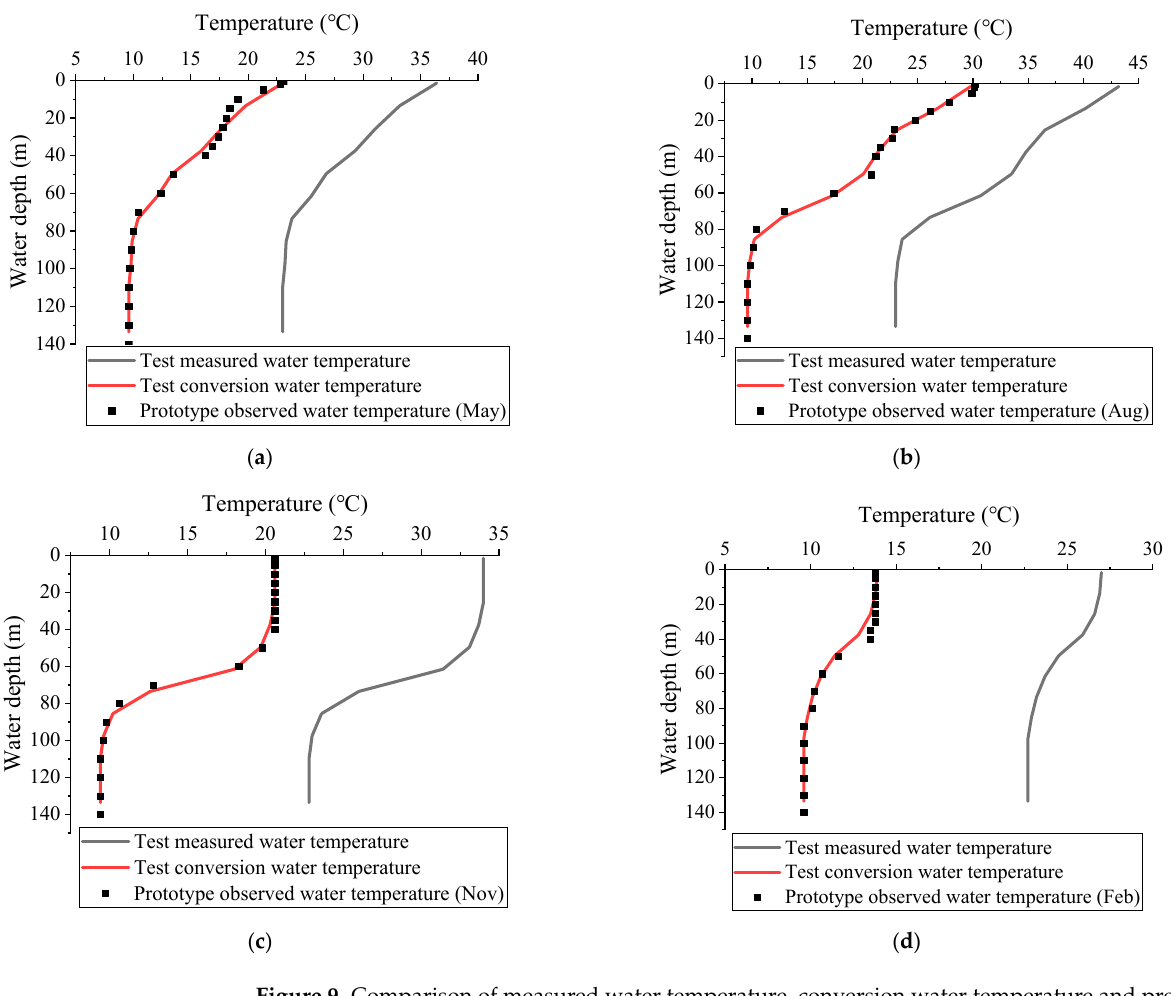
Figure 9. Comparison of measured water temperature, conversion water temperature and prototype observed water temperature: ( a ) May; ( b ) August; ( c ) November; ( d ) Next February.